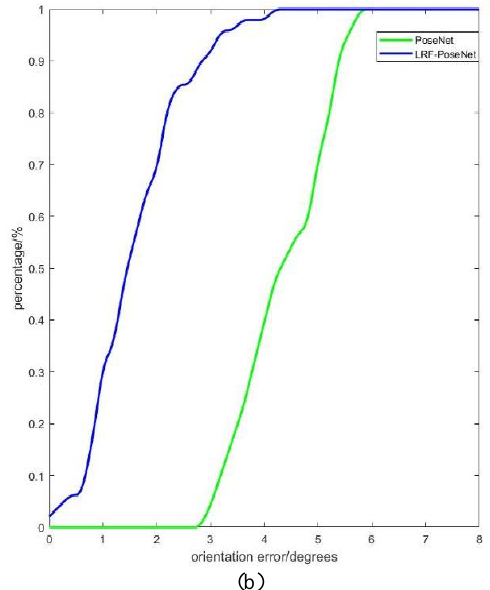
Figure 7 . Cumulative histogram of errors. (a–b) correspond to position error and orientation